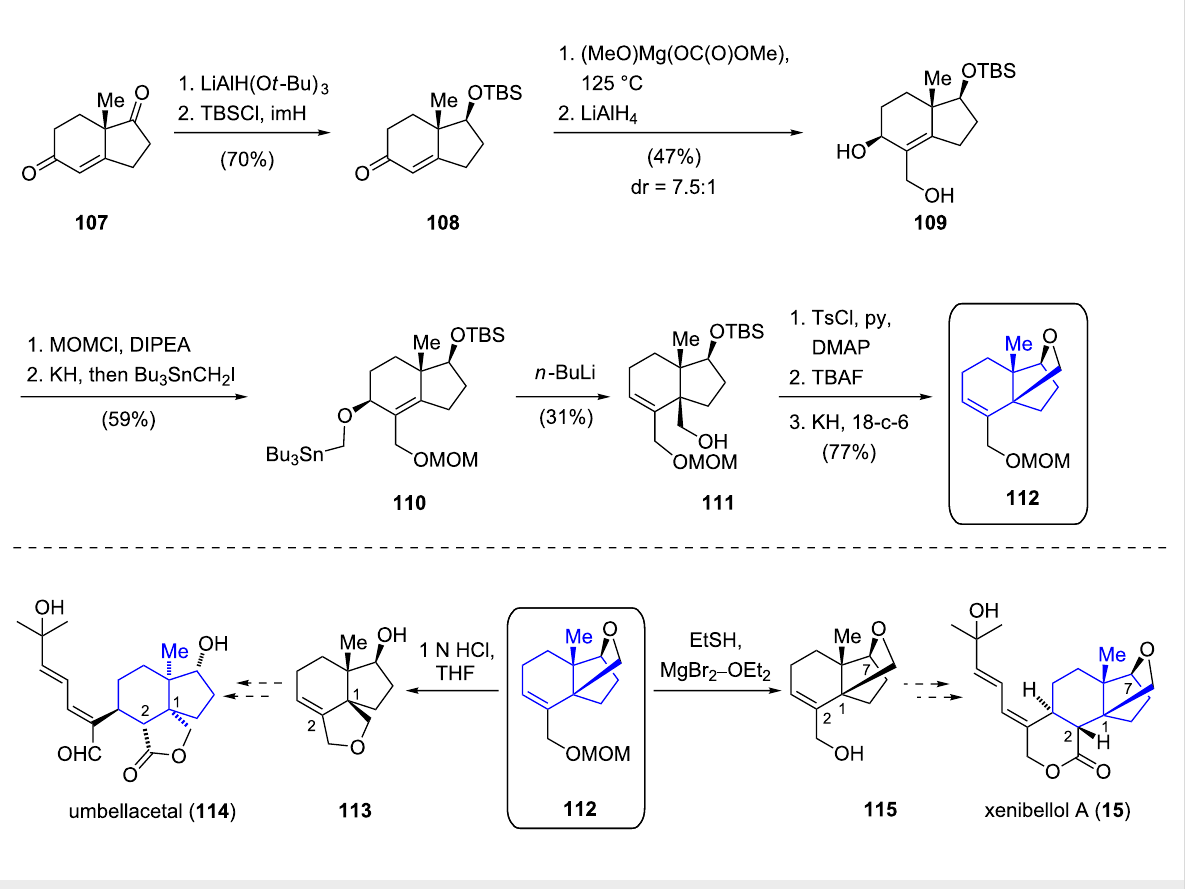
Scheme 11: Synthesis of the xenibellol ( 15 ) and the umbellacetal ( 114 ) core by